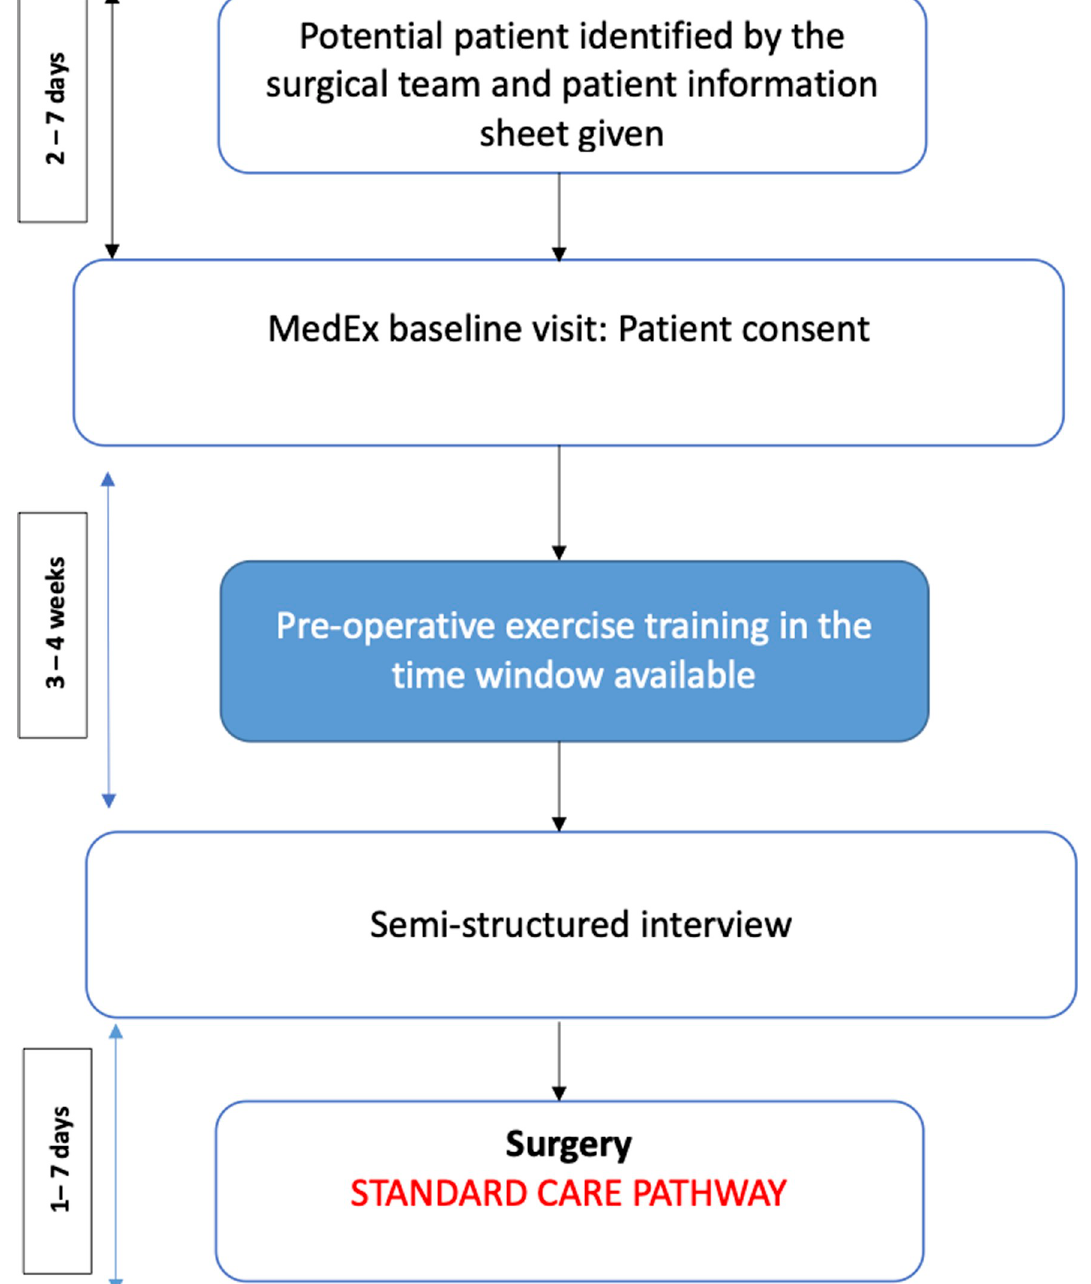
Fig 1. Study flow illustrating patient